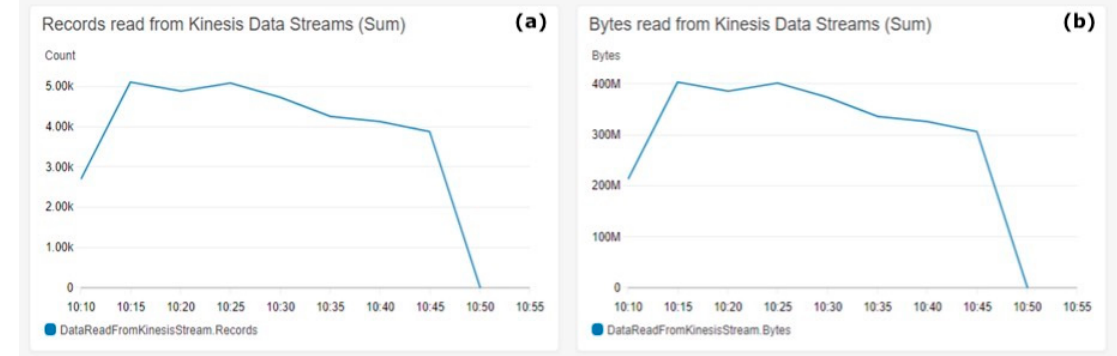
Figure 7. Kinesis Data Firehose reads. ( a ) Records read from the Kinesis Data Streams (sum), ( b ) Bytes read Kinesis Data Streams (sum).